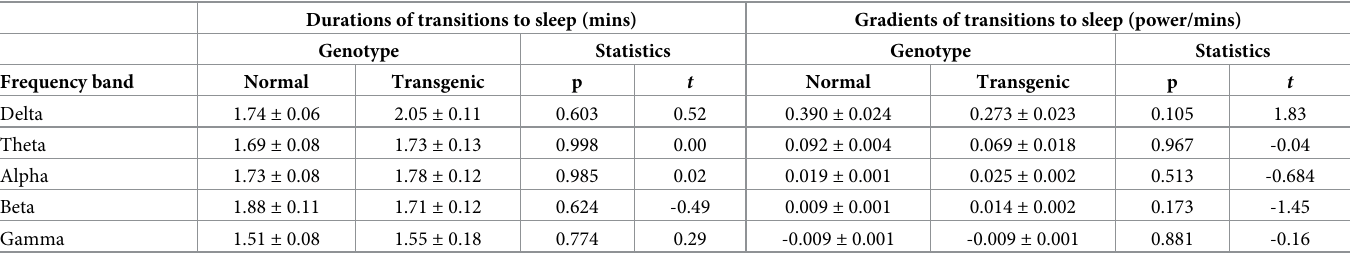
Table 3. Differences in durations and gradients of transitions to sleep for each frequency band between normal and HD transgenic